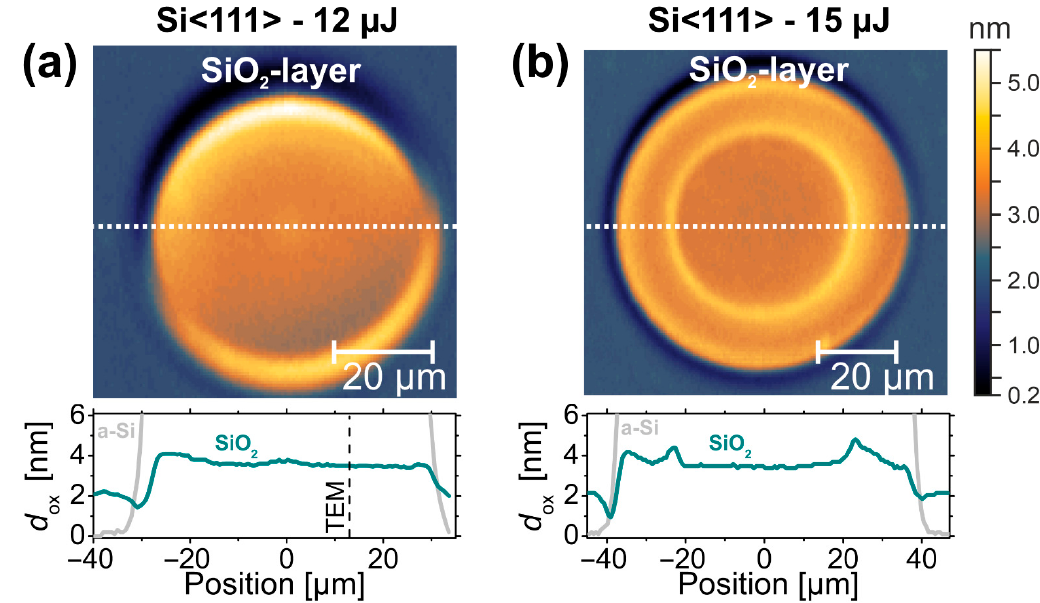
Figure 5. Top: maps of the silicon oxide layer thickness ( d ox ) as determined by SIE at the surface spots irradiated on Si<111> by a single laser pulse of ( a ) 12 µJ ( φ 0 = 0.24 J/cm 2 ) and ( b ) 15 µJ ( φ 0 = 0.30 J/cm 2 ); bottom: horizontal cross-sections (location indicated by a white dashed line) of the oxide (SiO 2 ) layer thickness (dark cyan curves) along with the data of the a-Si layer thickness (gray curves) for comparison. The vertical black dashed line in ( a ) indicates the position of the TEM/STEM measurements as marked by the red square in Figure 1. The thickness maps share a common color scale provided in ( b ). Note the different image sizes.